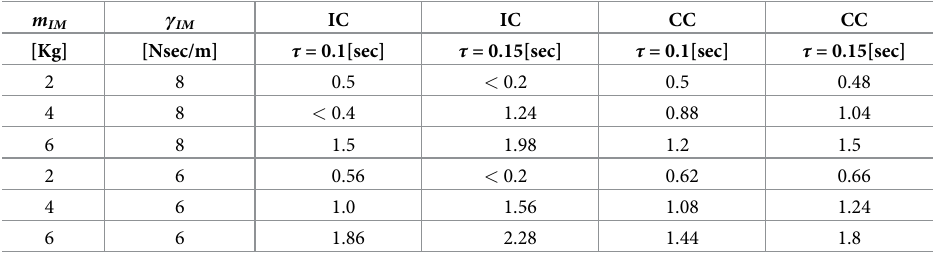
Table 1. Stability threshold: Minimum m PL [Kg] for which reaching movements with LTI plant, observer and con- troller are stable under CC or IC with h = 0.2[sec]. m IM γ IM IC